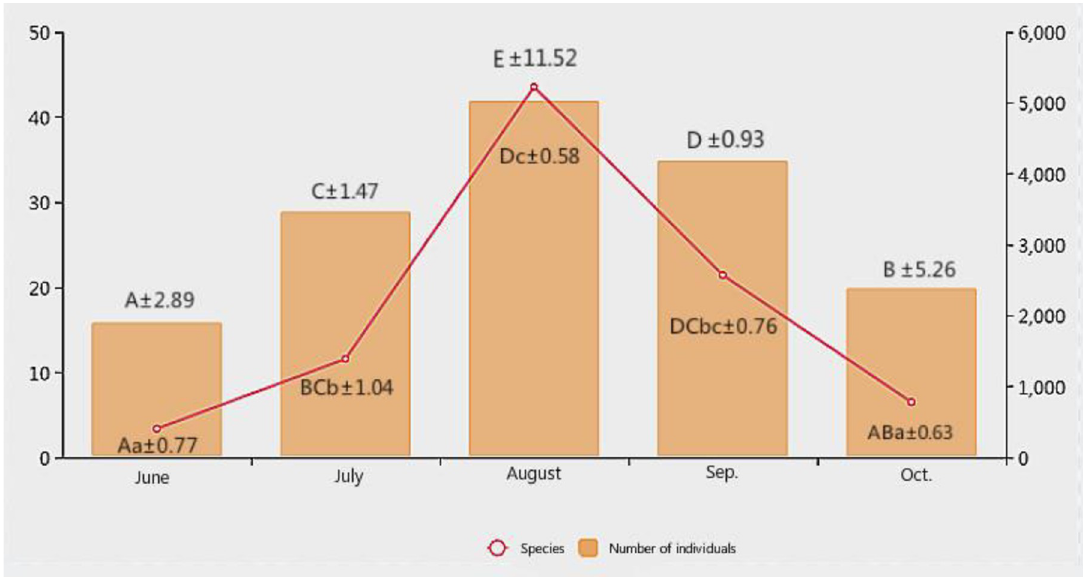
Fig 3. Analysis on difference of species and individuals of insect population in farmland plots. This figure shows the significance analysis of the difference between the number of individual population months in June, July, August, September and October, and the significance analysis of the difference between the number of species months (P <